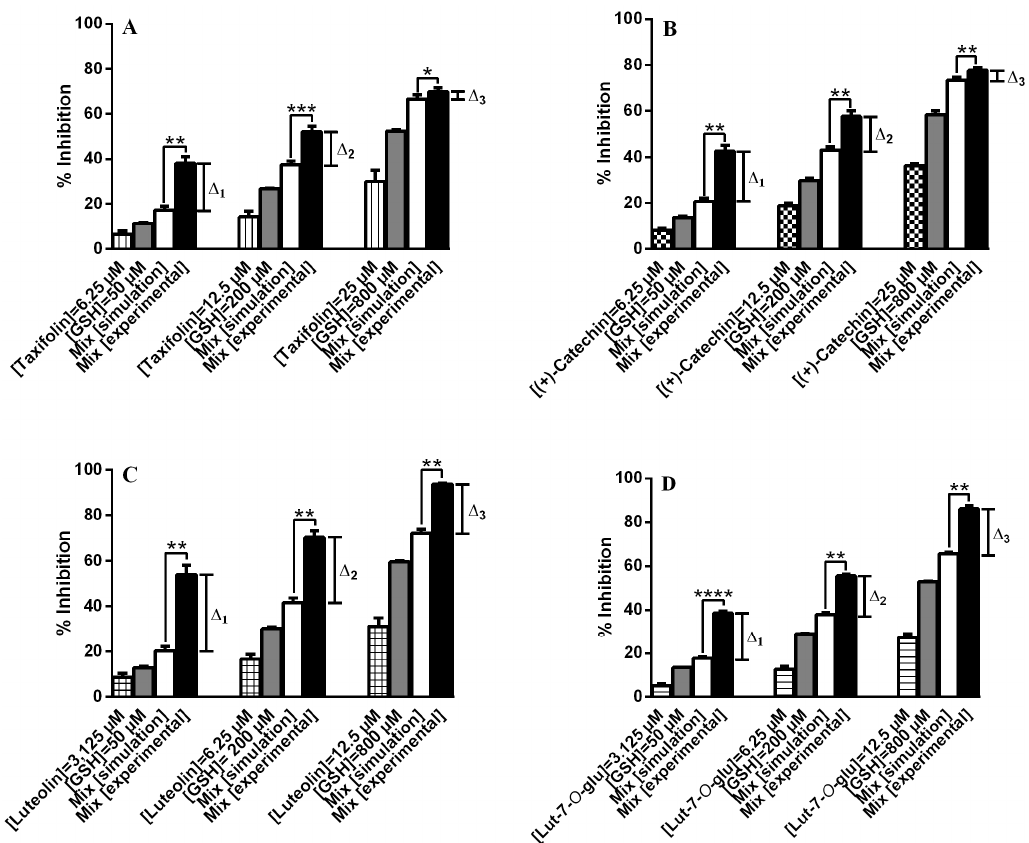
Figure 4. Antioxidant activity of binary mixtures of other classes of flavonoids (( A ) Taxifolin; ( B ) (+)-Catechin; ( C ) Luteolin; ( D ) Luteolin-7- O -glucoside) with GSH (mean ± SEM of three determinations). * p < 0.05, ** p < 0.01, *** p < 0.001, **** p <